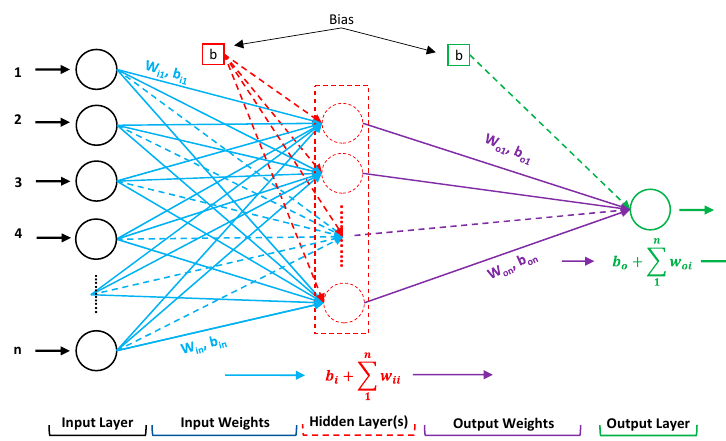
Figure 1. A typical layout of ANN with a single hidden layer.